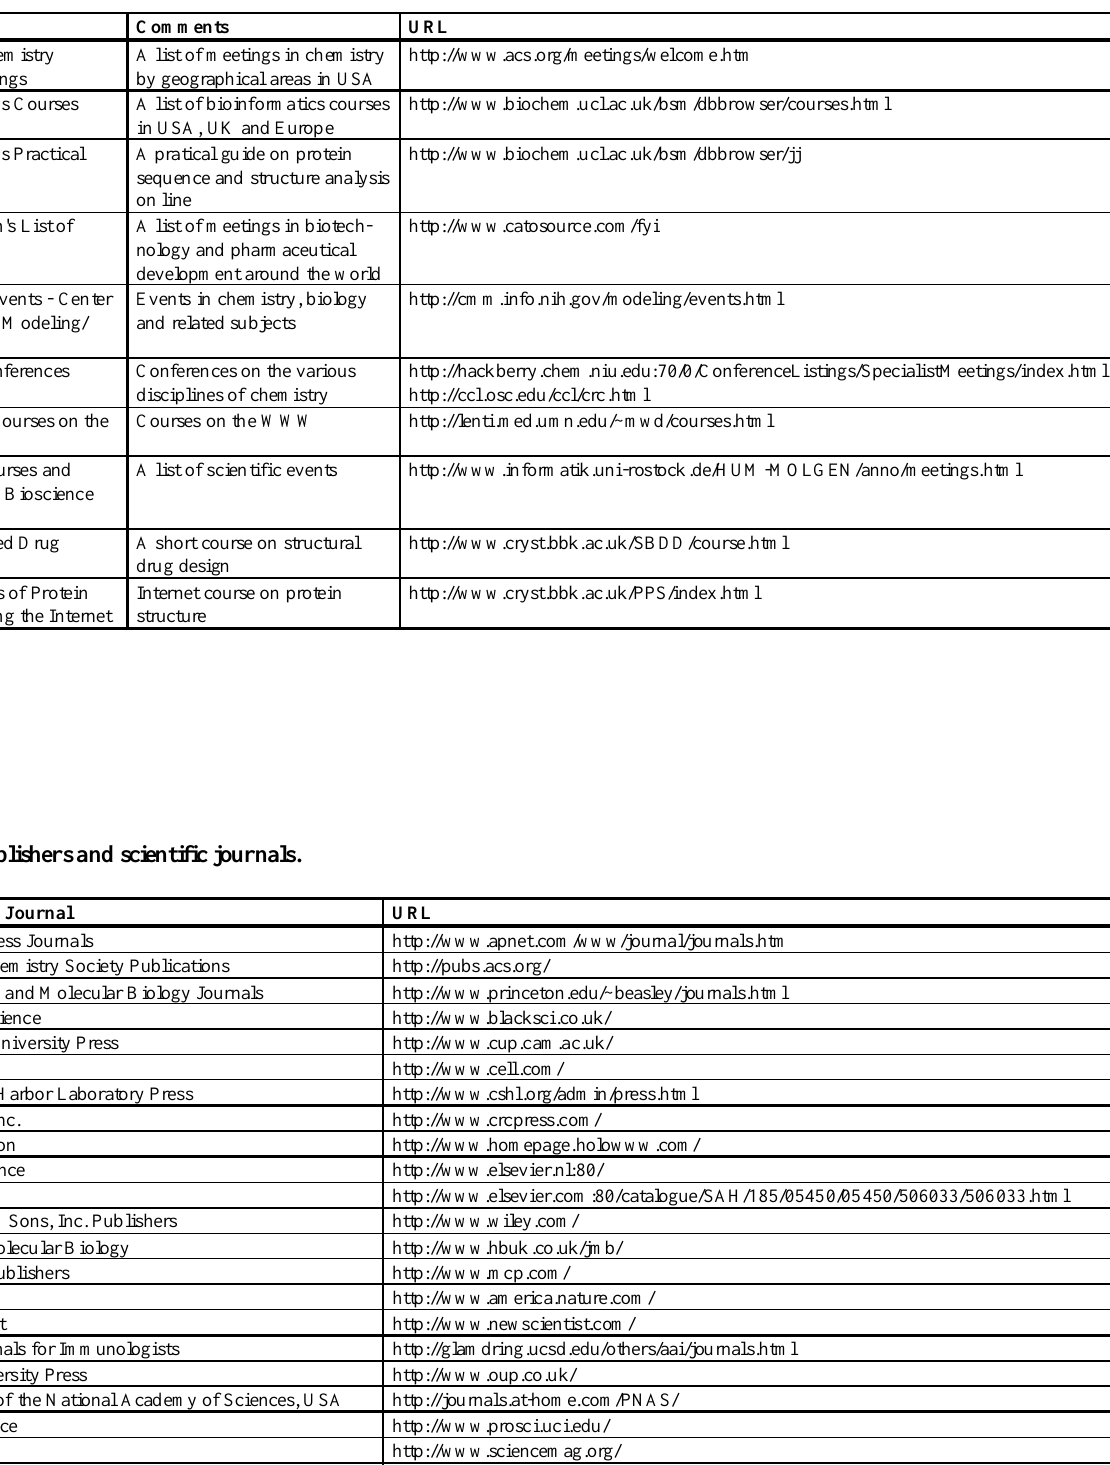
Table 4 - Meetings, courses and workshops on protein and related areas.